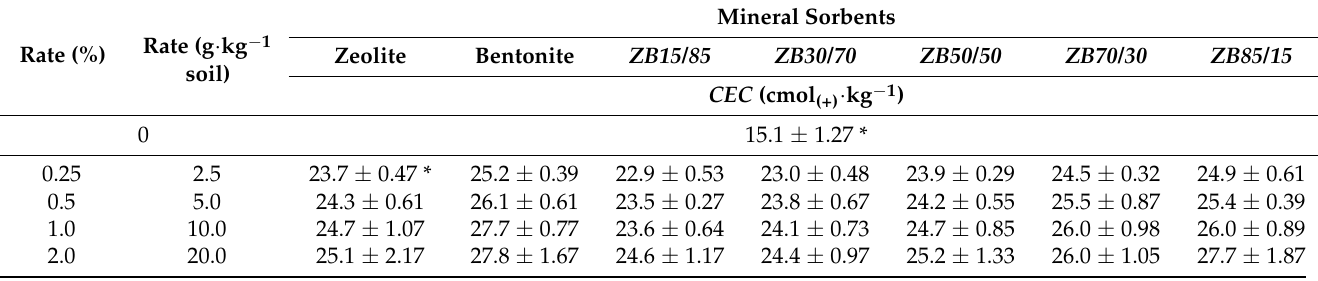
Table 3. Changes of buffering properties ( CEC ) of the treatment soils after application of mineral sorbents and 115 days of the aging